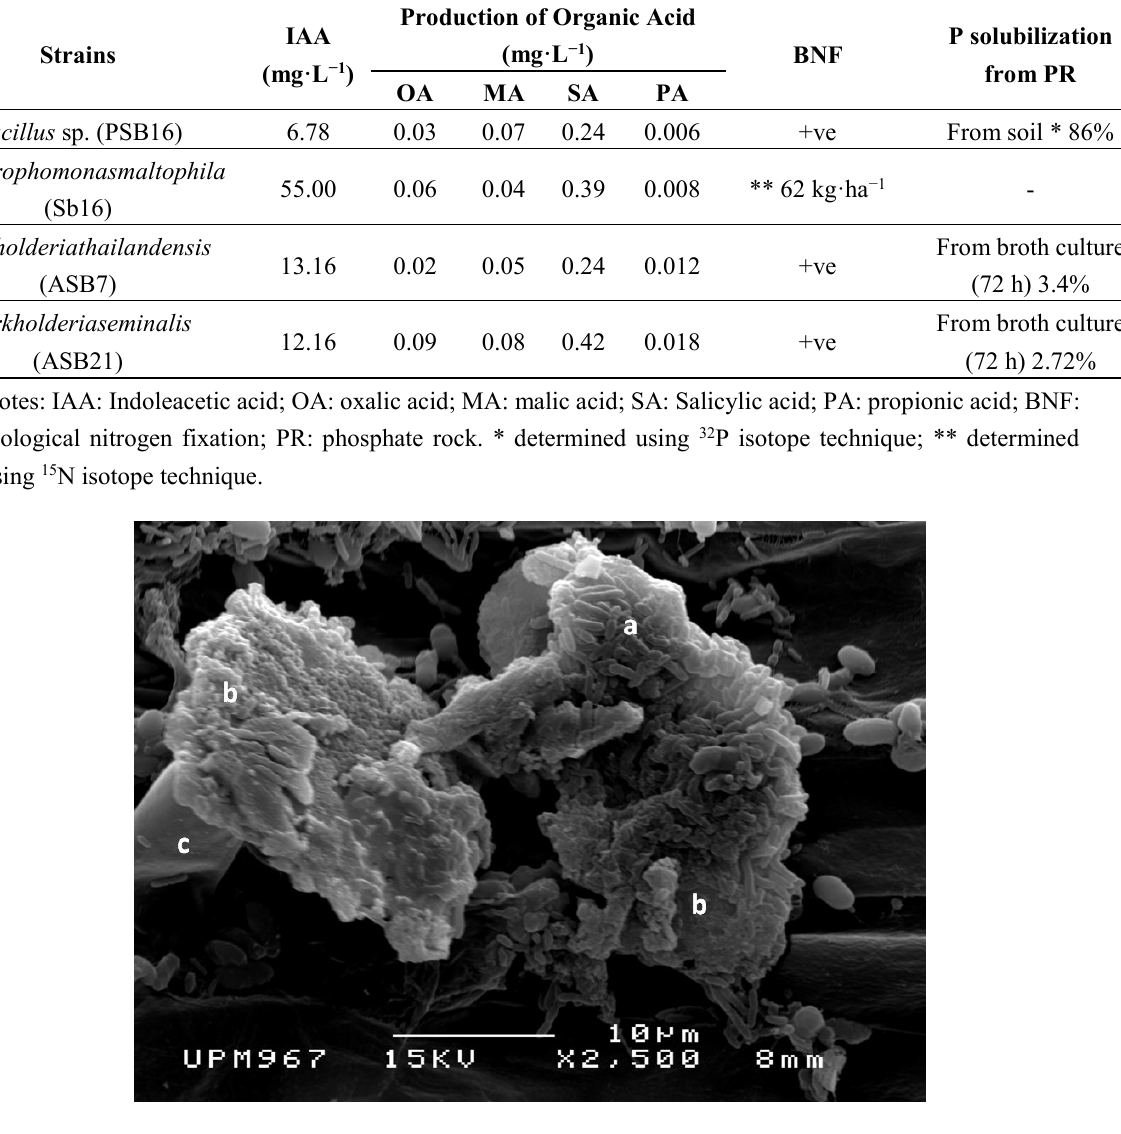
Figure 1. Exopolysaccharides production by the bacteria ( a ); showing gummy material ( b ) and covering root hair ( c